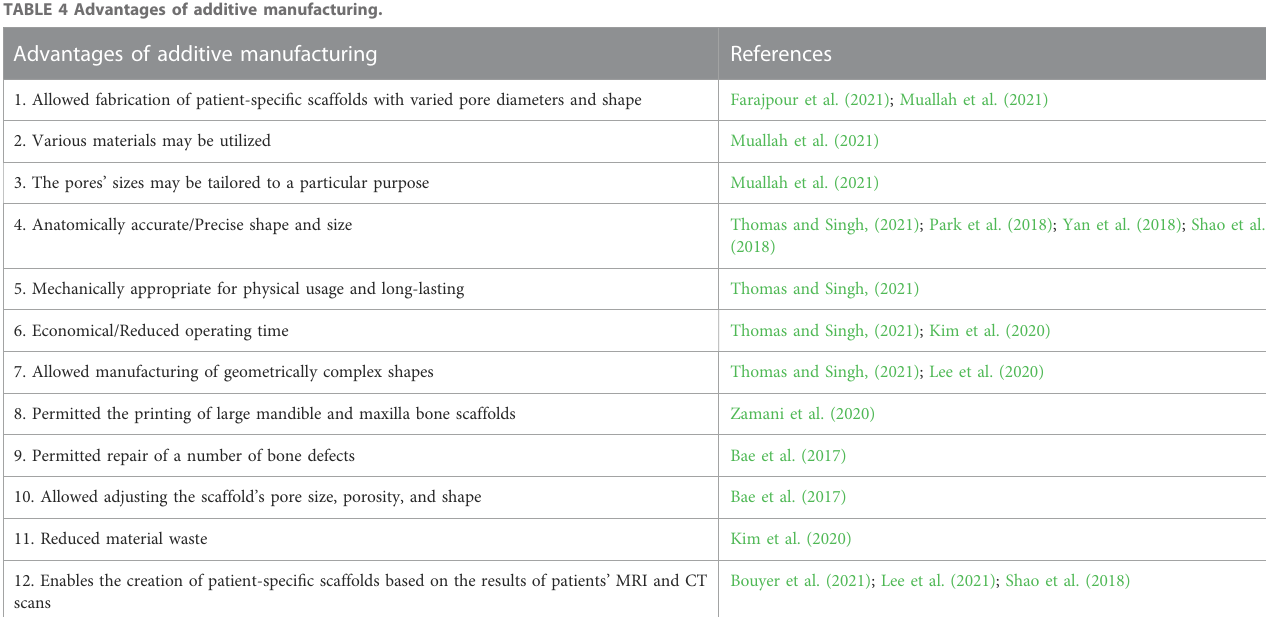
TABLE 4 Advantages of additive manufacturing.